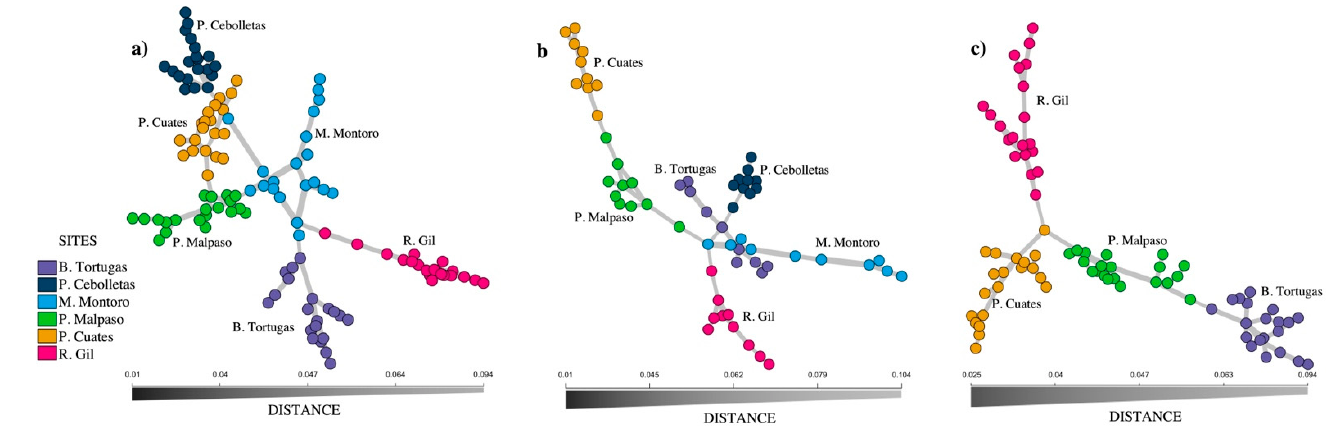
Figure 3. Minimum spanning network of the six populations of Pachyphytum caesium , without simulation ( a ); with simulation of the extraction of individuals ( b ); and the local extinction of two populations ( c ).